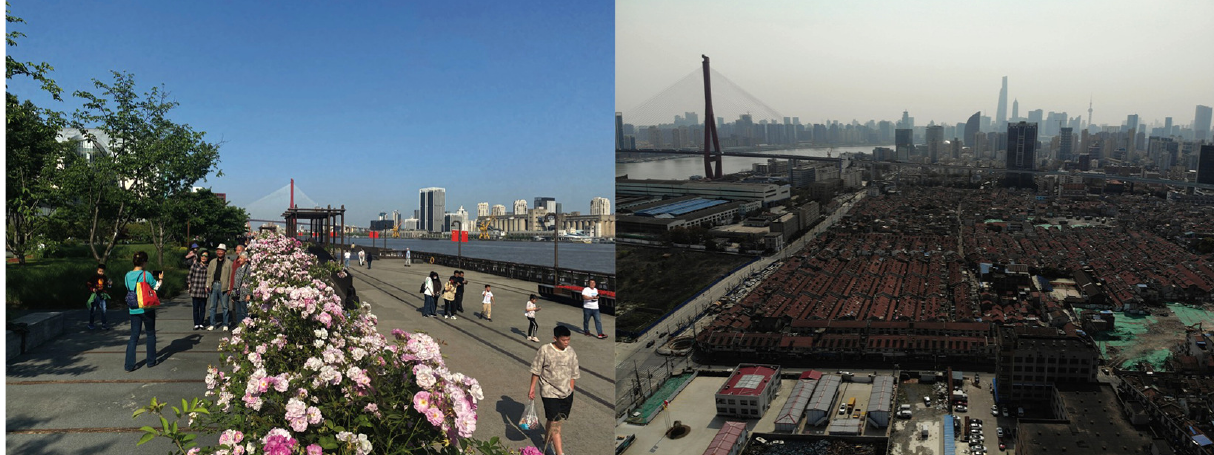
Figure 4. Behind the scenic Yangpu waterfront, working‐class neighbourhoods are being demolished. Source: Author (May